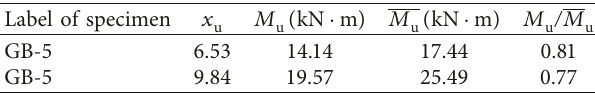
Table 13: Calculation of the cracking moment. Label of specimen x u